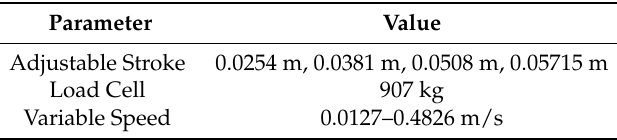
Table 2. Shock Dyno